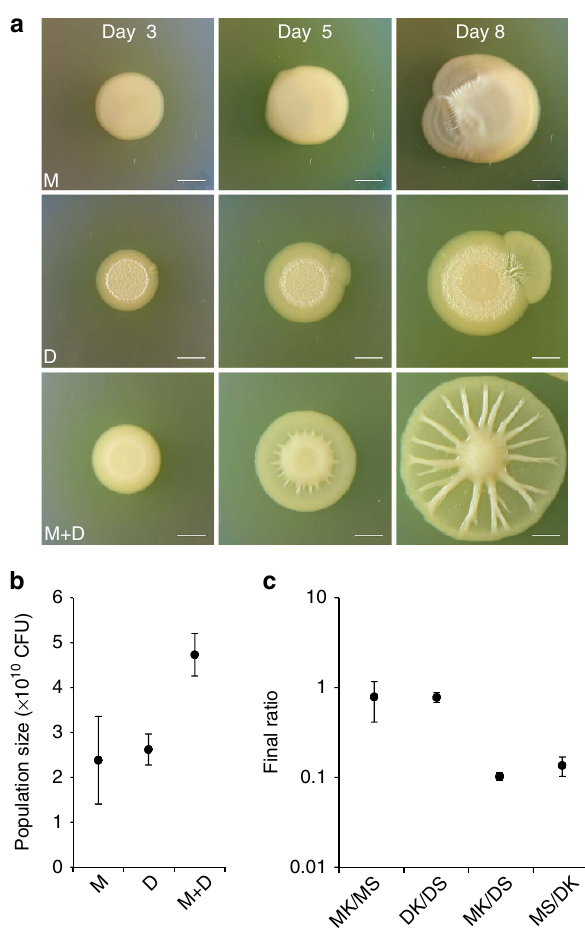
Figure 1 | Emergence of the spreading phenotype and comparison of the population size of single and mixed morphotype colonies. ( a ) Spreading fans emerge from a spotted mucoid M colony (top), comprising M and a genetic variant, D, exhibiting a dry colony morphology. The same phenotype emerges from D (middle), and is reproduced by mixing M and D (bottom).